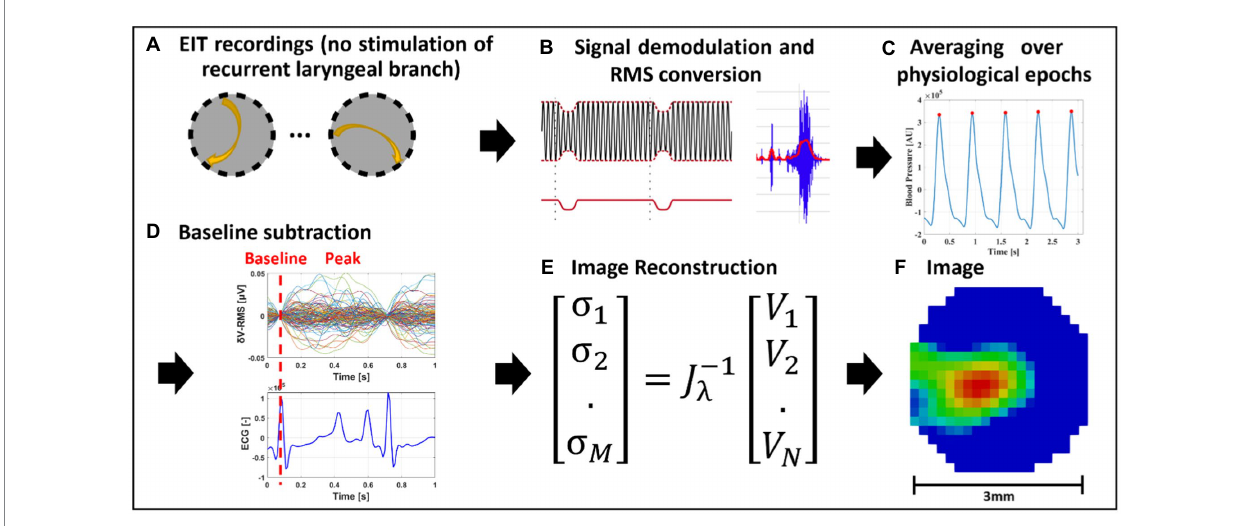
FIGURE 2 EIT of spontaneous neural activity. (A) EIT recordings are performed for multiple injection pairs on the cervical vagus nerve cuff. (B) Raw EIT data is demodulated, band-pass filtered and converted to RMS signal ( δ V-RMS). (C) Coherent averaging of RMS-converted EIT data is performed over epochs of periodic physiological signals (e.g., heartbeat or breathing). (D) Baseline subtraction is performed over δ V-RMS traces at a time point corresponding to low or absent neural traffic. (E,F) Tikhonov-based reconstruction is performed to obtain a conductivity map over the cross-section of the nerve. The color scale is arbitrary units (Z score of relative change in the modulus of the